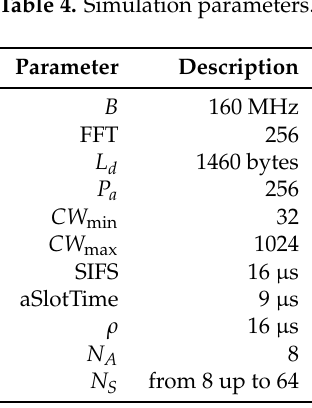
Table 4. Simulation